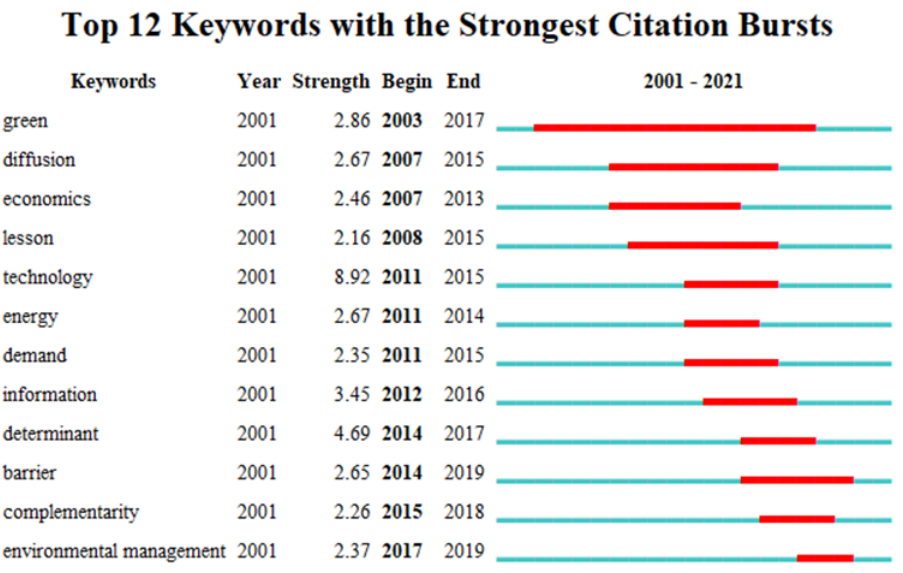
Figure 12. CiteSpace-based emergent word mapping.